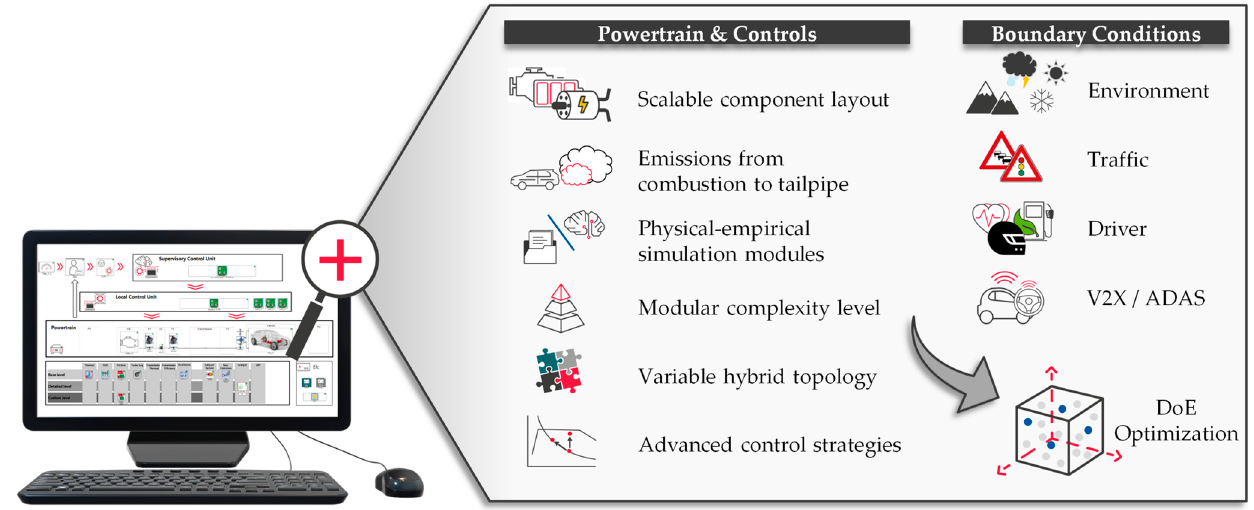
Figure 4. Vehicle simulation methodology for hybrid electric vehicles. (DoE: Design of Experi- ments, V2X: Vehicle-to-X, ADAS: Advanced Driver Assistance Systems)